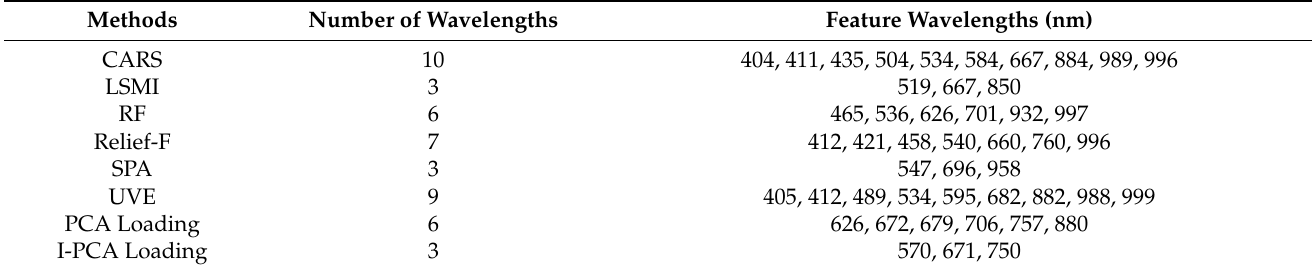
Table 4. Results of different feature wavelength selection methods.